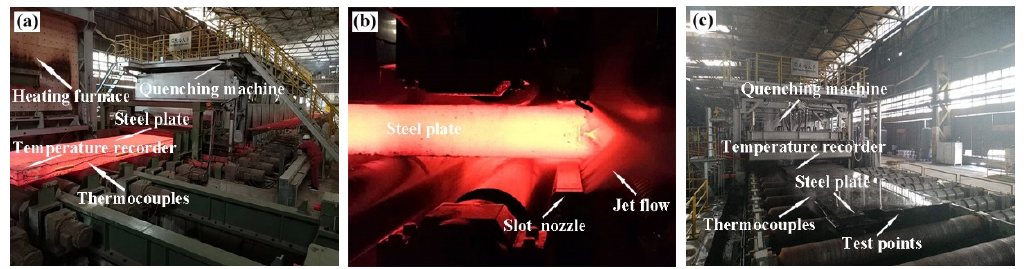
Figure 2. Images of experimental equipment and steel-plate quenching process: ( a ) before quenching, ( b ) quenching, and ( c ) after quenching.